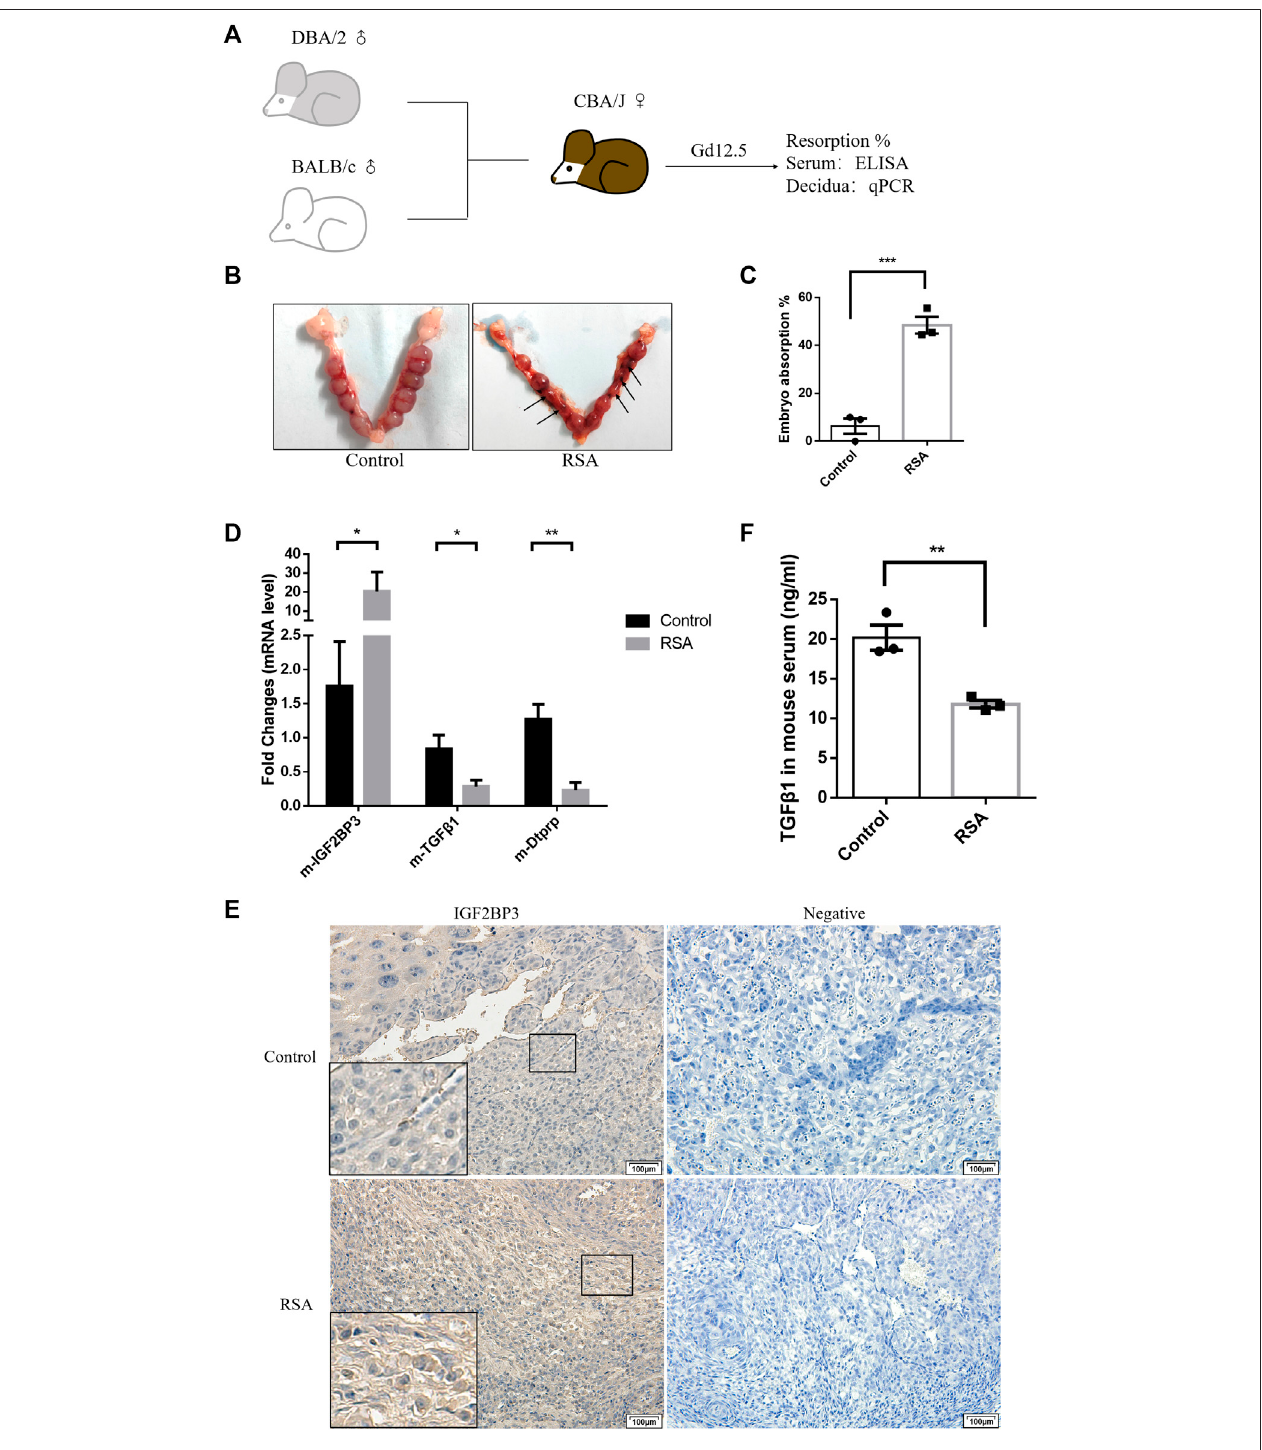
FIGURE 6 | IGF2BP3 and TGF- β 1 in the mouse abortion model (A) construction process ofthe mouse abortion model, (B,C) con fi rmed the success of the animal model by statistically analyzing the embryo resorption rate, (D) IGF2BP3, TGF- β 1, and Dtprp mRNA levels in the decidual tissues of RSA mouse, and controls were measured by qPCR, (E) immunohistochemical staining showed the localization and relative quanti fi cation of IGF2BP3 in the decidual tissues of recurrent spontaneous abortion (RSA) andnormalpregnancy(HC)modelmice.Brown stainingrepresents thetargetprotein. Insertsshowahighermagni fi cationofthesquare area.Scale bar=100 μ m,and (F) expressionlevelsofTGF- β 1intheserumofmiceinRSAandcontrolgroupsweredeterminedbyELISA. n =3foreachgroup.* p < 0.05,** p < 0.01, and *** p < 0.001 vs. control.